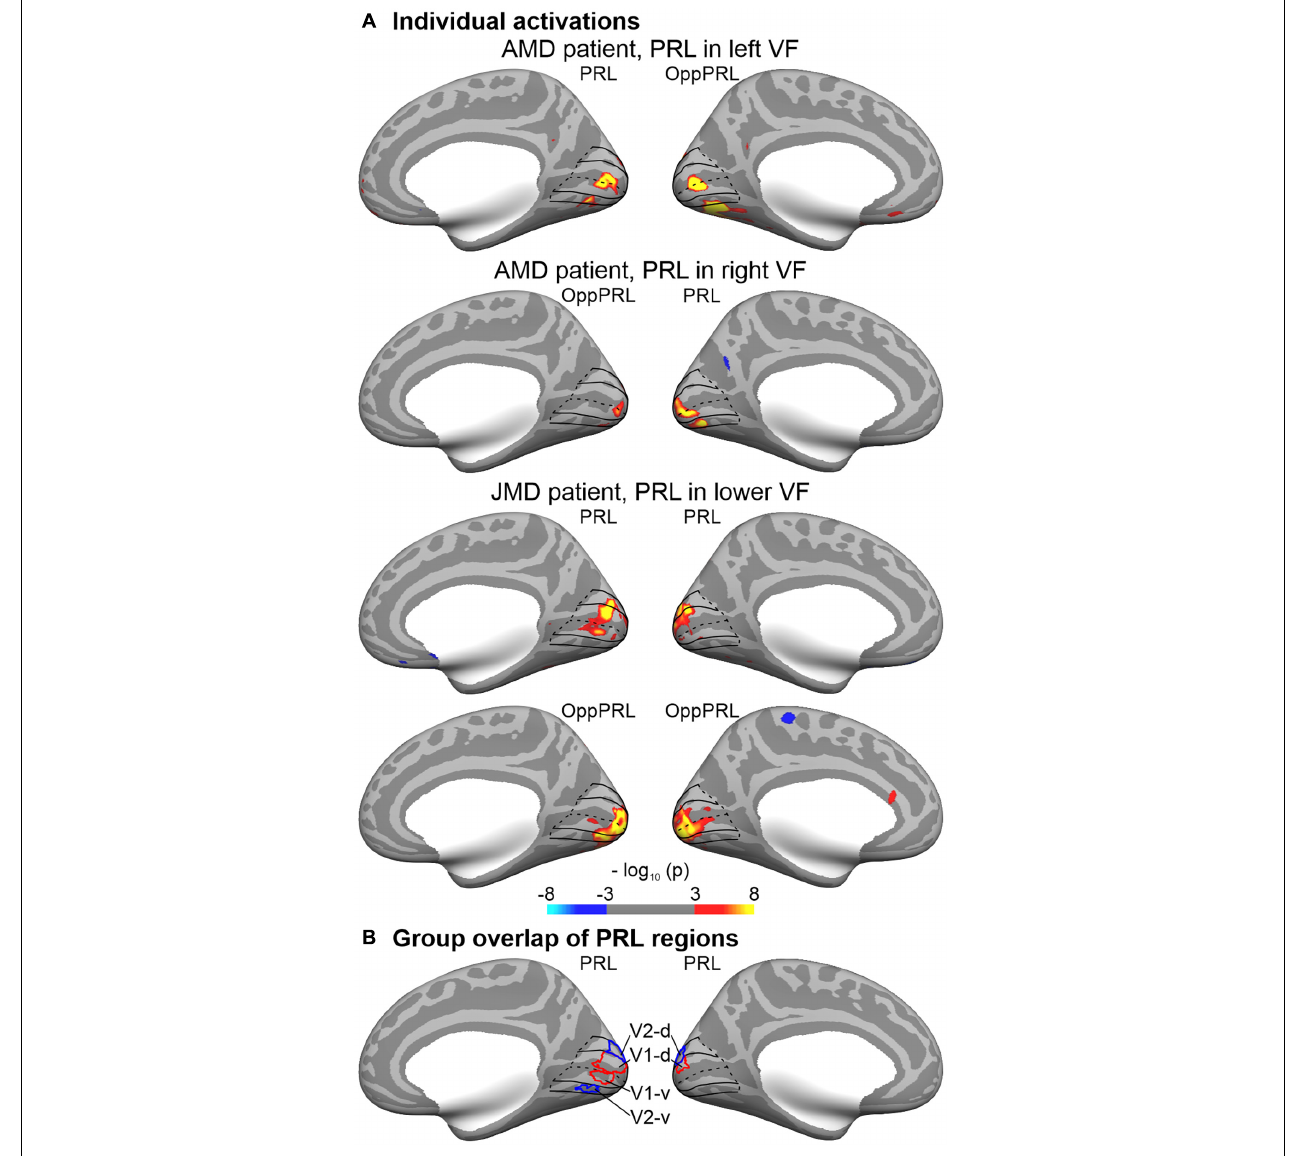
FIGURE 2 | Regions-of-interest (ROIs) of the preferred retinal location (PRL). (A) Individual functional MRI maps show significant activation for the stimulation of the PRL part of the visual field or the control region (OppPRL), respectively, for three representative patients with a PRL in the left, right, or lower visual field (VF), respectively. All maps were thresholded ( p ≤ 0.001; uncorrected) and color-coded (red/yellow: stimulation > baseline; blue: stimulation < baseline). In order to facilitate comparison, individual maps were projected (by spherical registration) to the inflated cortical surface of the Freesurfer average brain. Only the most relevant views (medial, hemispheres contralateral to stimulation) are depicted. ROIs of the PRL and OppPRL regions were identified in each patient based on the individual maps (see text for details) and further sub-divided into V1 and V2 parts based on a retinotopic template (Benson et al., 2014). The outlines of V1 and V2 are shown in black lines for reference. Note that dorsal (d) and ventral (v) parts were combined for the cortical thickness analyses. (B) The outlines show the group overlap of at least 8 (out of 32) selected PRL regions in V1 (red) and V2